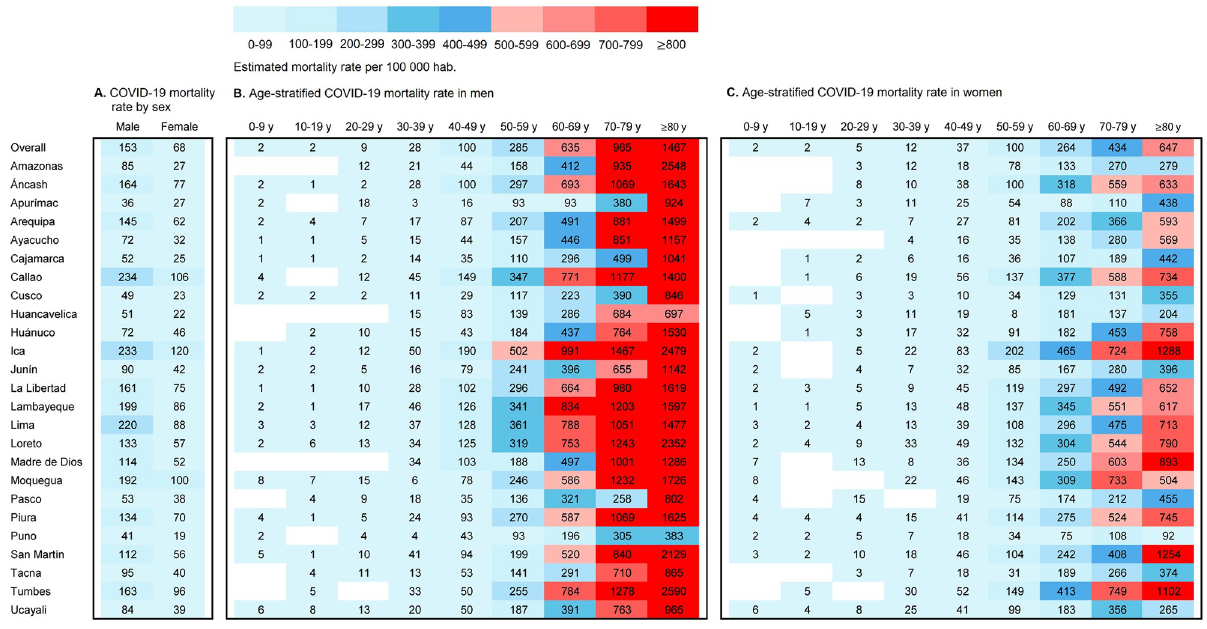
Fig 2. Sex and age-stratified COVID-19 mortality estimates by region (A, B and C), Peru, 2020.